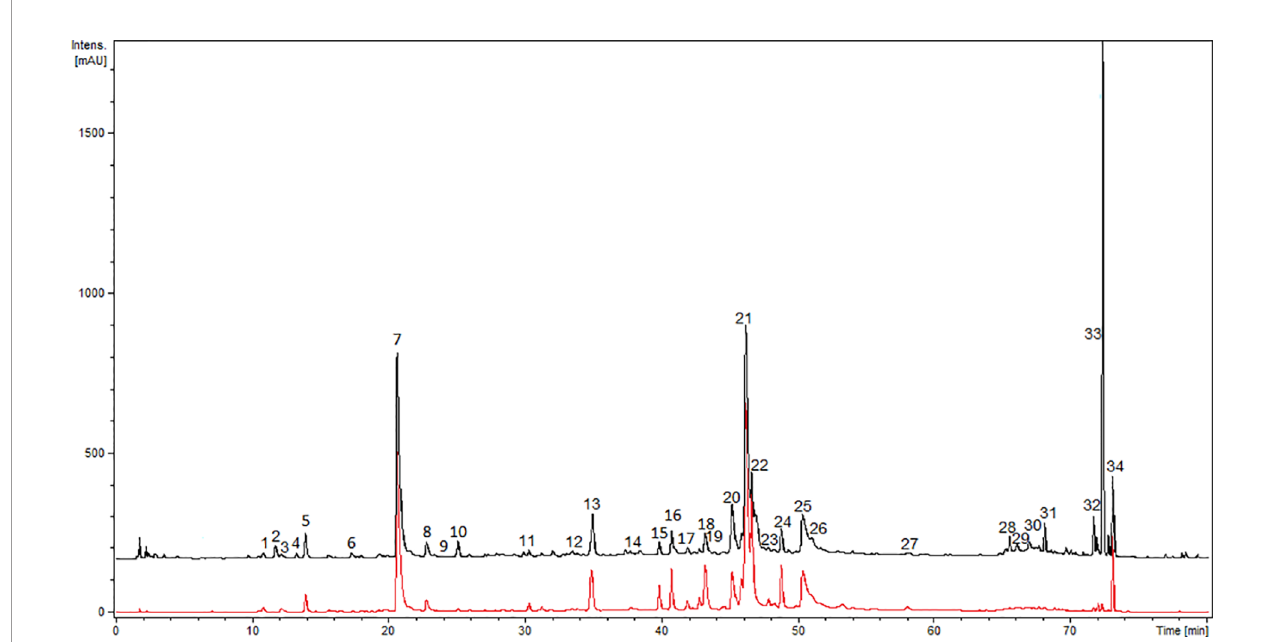
FIGURE 1 | UHPLC-DAD-ESI-MS/MS chromatograms of ADI recorded at 280 nm (black line) and 350 nm (red